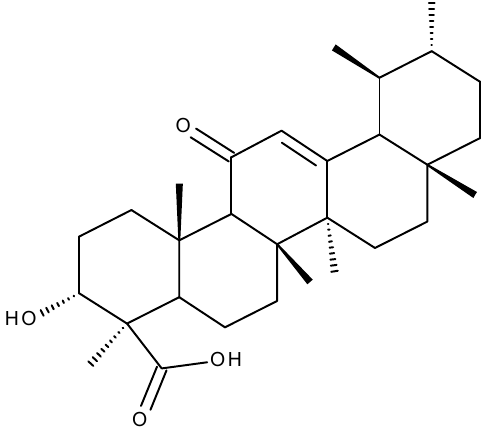
Figure 6. Structure of boswellic acid.